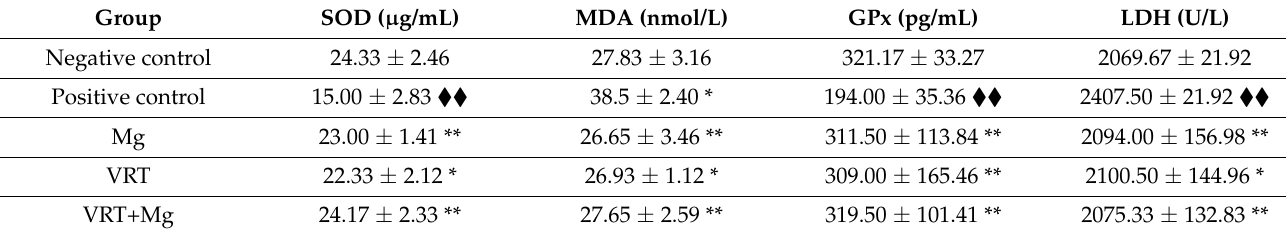
Table 2. The effects of VRT, Mg and VRT+Mg on the activity of SOD, MDA, GPx and LDH in treadmill test in rats. Each point represents the mean ± S.D. of the average values, for 6 animals per group. The values of the coefficient (cid:7)(cid:7) p < 0.01 were considered statistically significant versus negative control; ** p < 0.01, * p < 0.05 were considered statistically significant versus positive